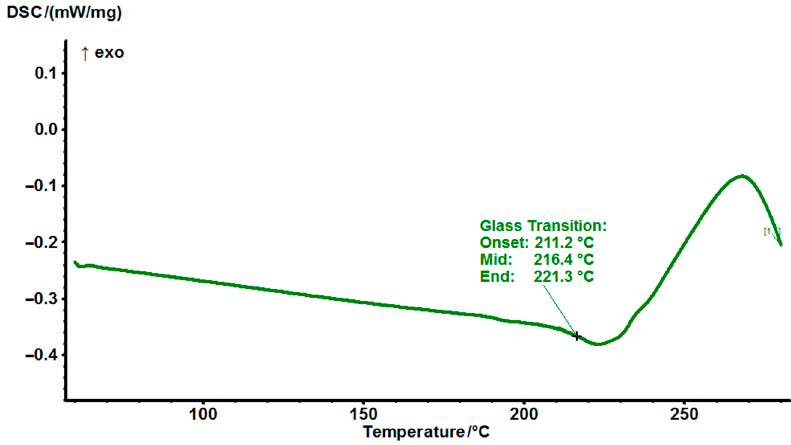
Figure 6. DSC thermograms cured EG513 at a heating rate of 10 ◦